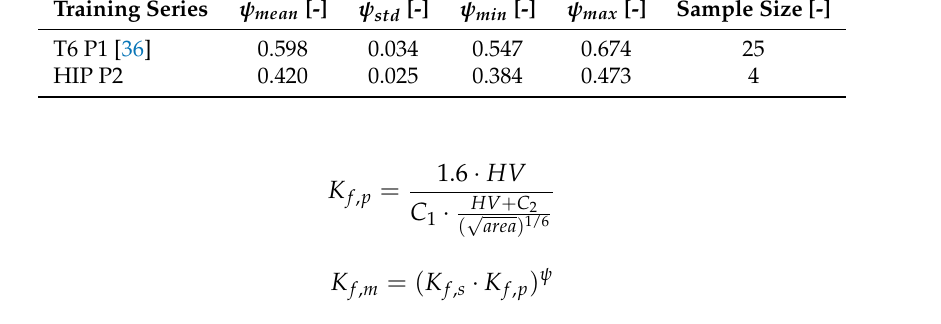
Table 6. Evaluated interaction coefficients of the NN training series of T6 P1 [36] and HIP P2. Training Series ψ mean